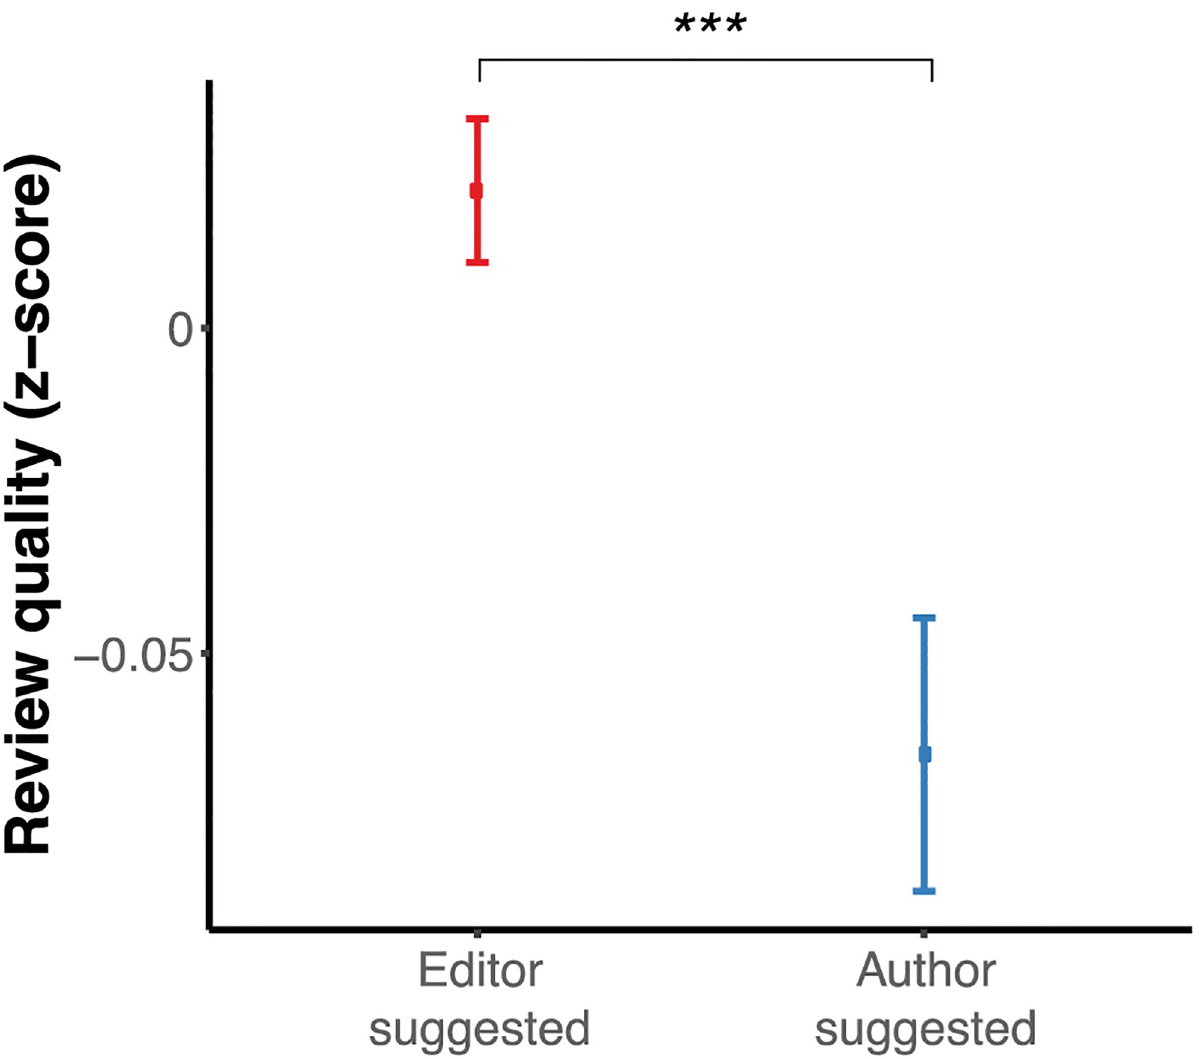
Fig 4. Author-suggested reviewers produce reviewers that are judged as lower quality by editors. The point is the mean and the error bars are the standard errors of the mean (SEM). For comparison across means, the asterisk indicates the statistical significance of a two-sample t test where " ��� ", " �� ", and " � " represent p < 0.01, p < 0.05 and p < 0.1,